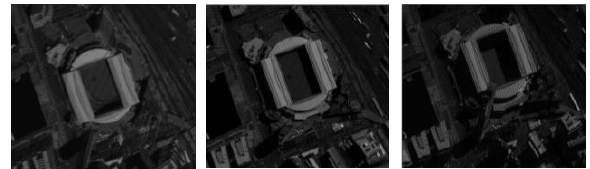
Figure 7. Illustration of the Melbourne Pléiades sequence, on first, nadir and last image. All these were reprojected on a plane with constant height, the attitude were corrected through refining using Euclidium.